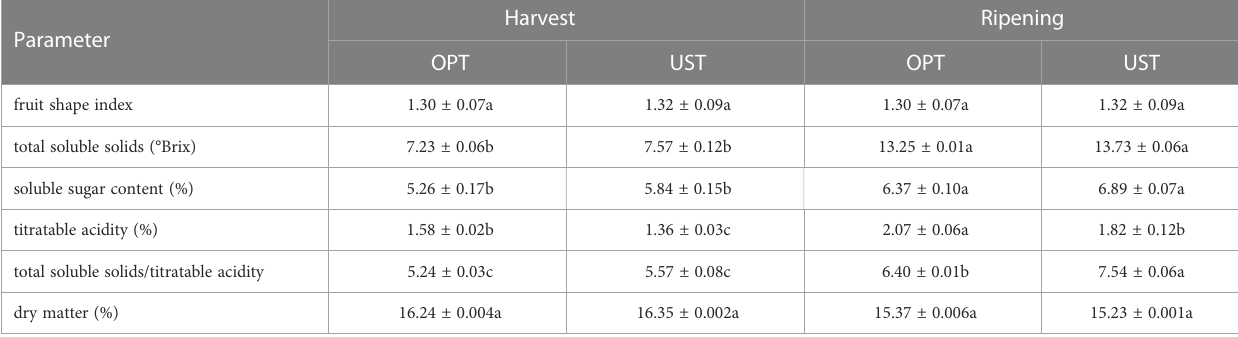
TABLE 2 Extrinsic and intrinsic quality parameters in the OPT and UST-treated Donghong kiwifruit at harvest and after storage (ripening).